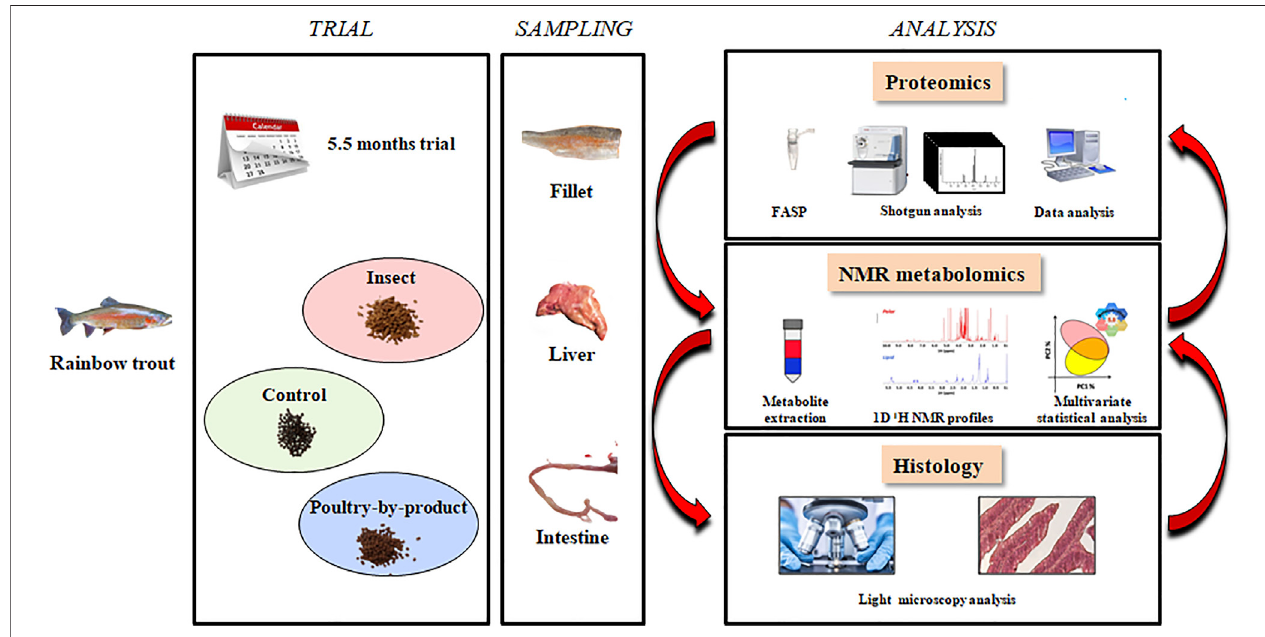
FIGURE 1 | Work fl ow in the proteomics, metabolomics and histology experiments.